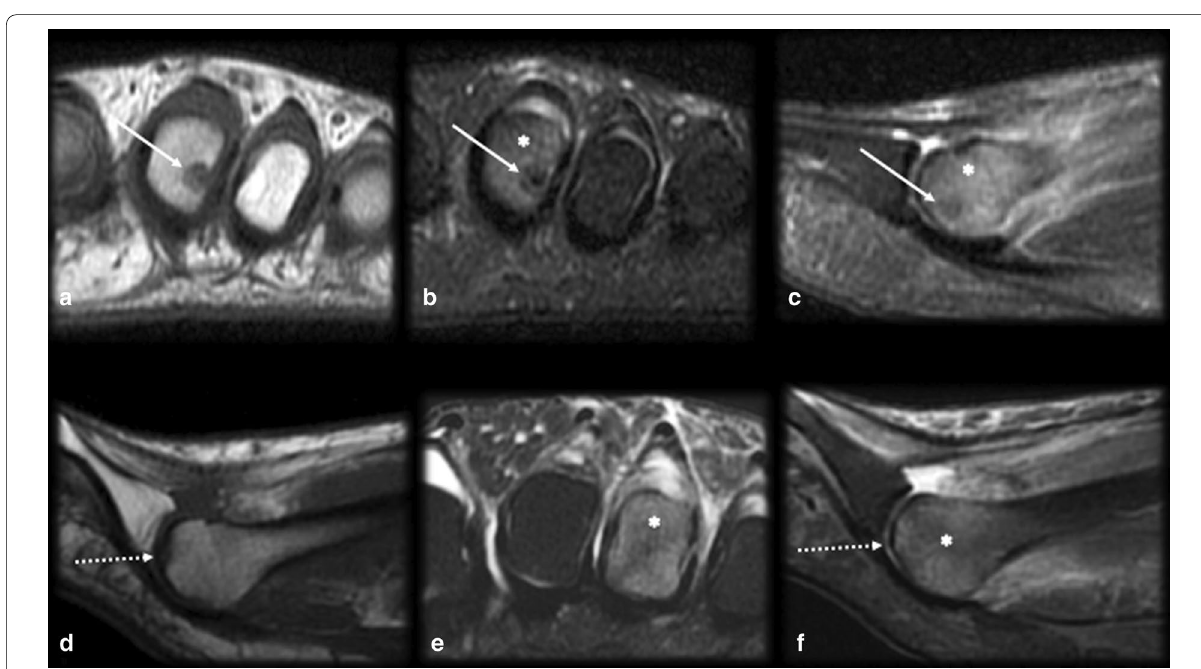
Fig. 10 Osteoid osteoma versus tibial stress syndrome. A 15-year-old male soccer player with posteromedial tibial pain for 3 months that worsened while training and upon palpation of the upper posteromedial tibia. MRI axial T1 ( a ), axial ( b ) and coronal ( c ) T2 FS showed cortical thickening, periosteal reaction, pes anserinus tendon edema (arrows) and bone marrow edema (asterisk), mimicking a stress syndrome. Further investigation with a CT scan ( d , e , f ) demonstrated a nidus (dashed arrow), causing this corticoperiosteal reaction (arrowhead) and confirming OO